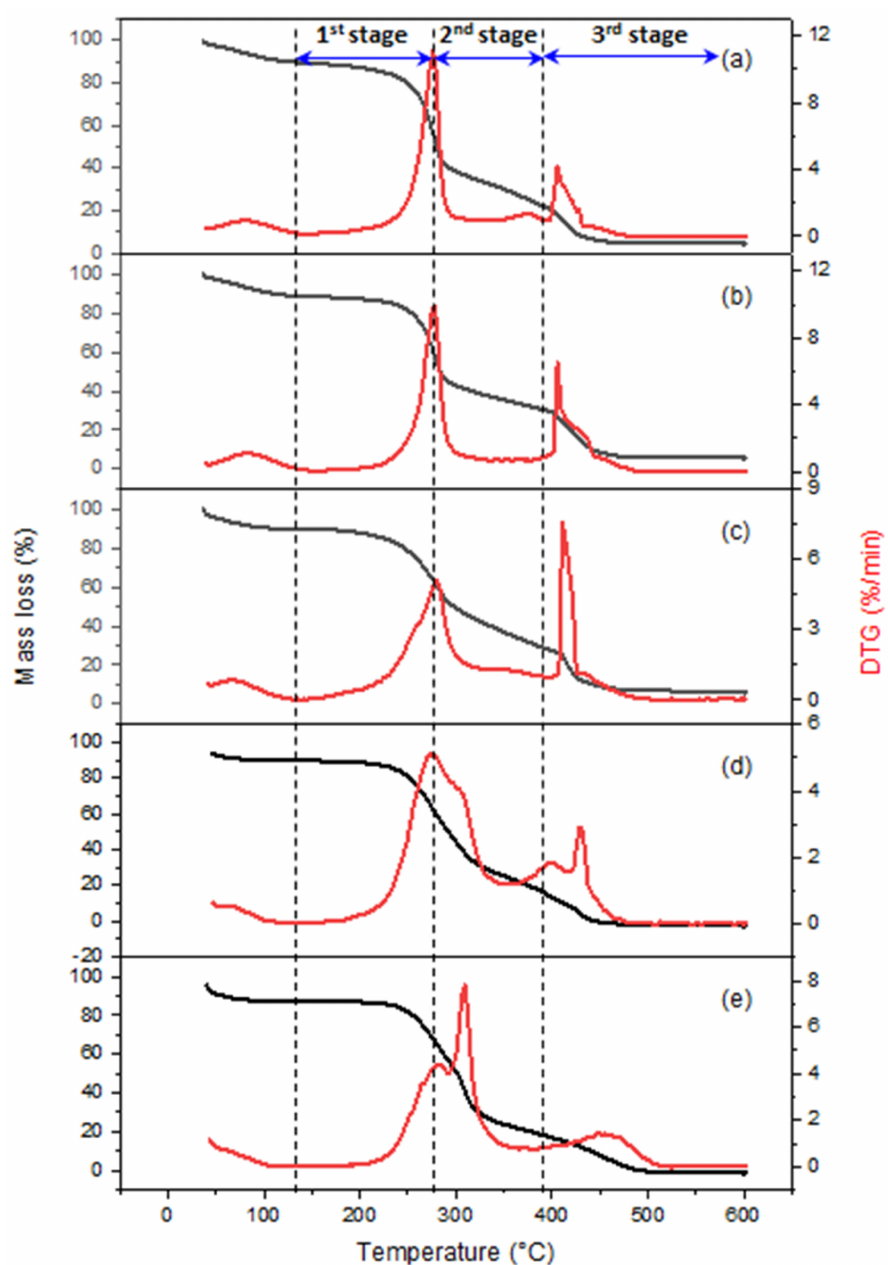
Figure 2. TG (black curve and y-axis on the left side) and DTG (red curve and y-axis on the right side) profiles of untreated residues of ( a ) cassava, ( b ) yam, ( c ) coconut, ( d ) corncob, and ( e )